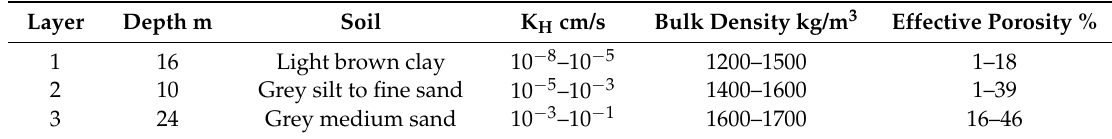
Table 2. Soil properties of the three layers.